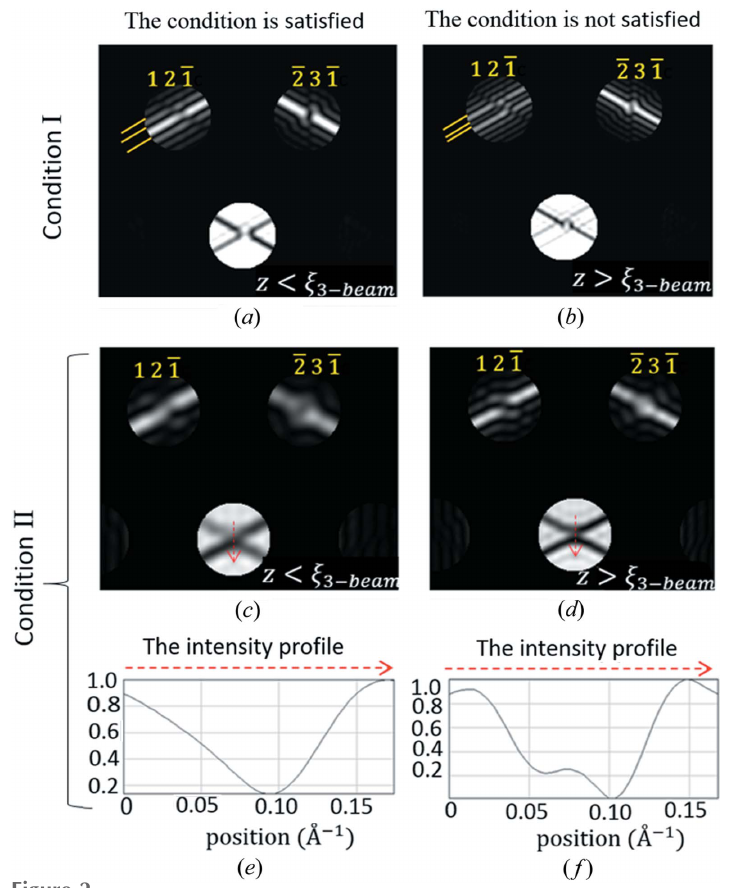
Figure 2 Illustration of Criterion 2 with simulated CBED patterns from alpha-quartz (space group P 3 1 21) near [ (cid:3) 11 (cid:3) 33 (cid:3) 77] at 200 kV. Condition I is satsified in ( a ) but not in ( b ). The yellow lines label the width of the first bright fringe relative to the second one. Condition II is satisfied in ( c ) but not in ( d ). The intensity profiles along the dashed red arrows in ( c ) and ( d ) are shown in ( e ) and ( f ), respectively. In the calculation of ( c ) and ( d ), the same set of parameters as those in the calculation of ( a ) and ( b ) were used except that the coupling structure factor, V , was artifically increased h (cid:4) g to produce a strong coupling case of three-beam diffraction as opposed to the weak/moderate coupling case in ( a ) and ( b